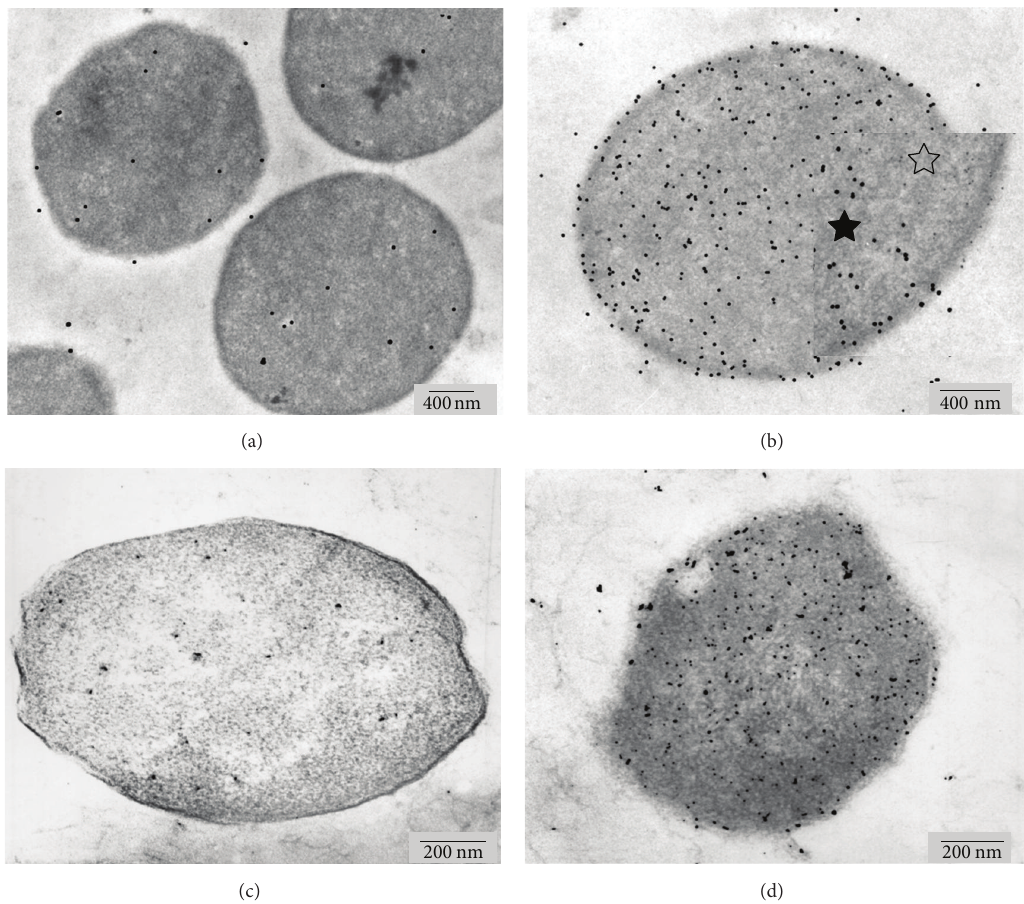
Figure 2: Ultrathin sections of Methanosarcina mazei (DSM 3318, formerly Methanosarcina frisia (a, b) and Methanococcus maripaludis (c, d) grown on media without nickel depletion. Immunolabeled cells (b, d; a, c are negative controls) show cytoplasmic localization of MCR. The inset in (b) shows an enlarged area of the image before (open star symbol) and after processing (closed star) of the gold marker.